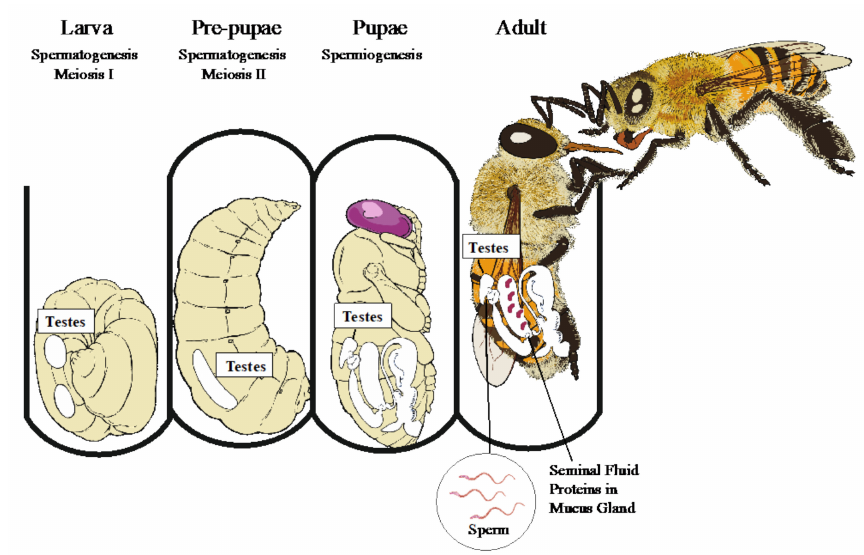
Figure 1. Sperm production in honey bee drones during development. Spermatogenesis, the production of sperm, occurs during late larval and pre-pupae development. Spermiogenesis, sperm differentiation, occurs during pupation. Once honey bee drones emerge as adults, sperm production is already complete. However, drones will produce seminal fluids in the mucus glands during early adult emergence. Photo credit: Amy Geffre.